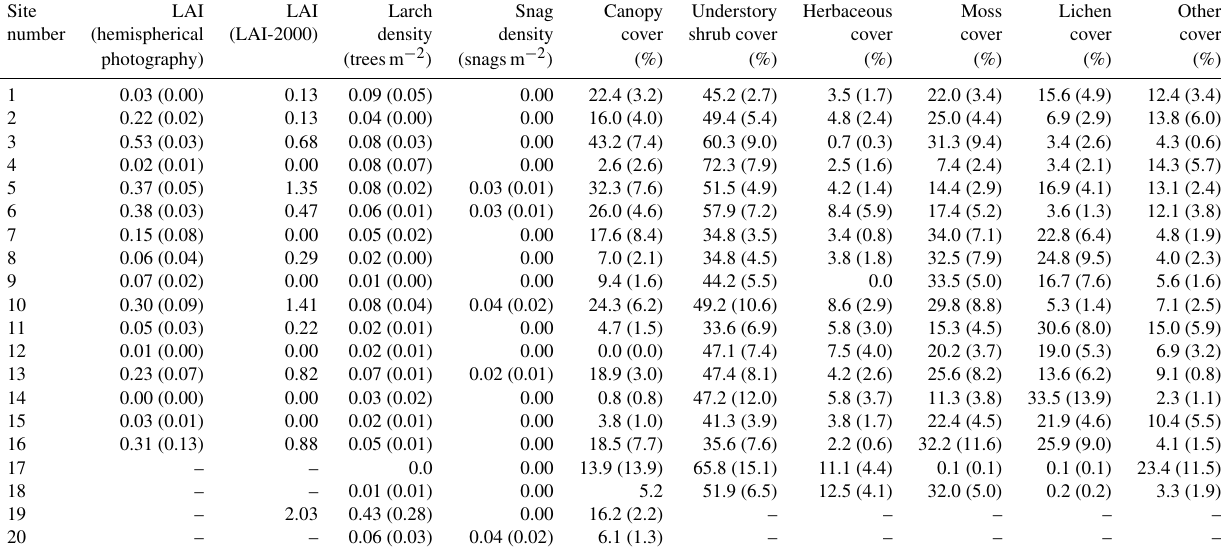
Table 2. Leaf area index (LAI), tree and snag density, and percent cover of the 20 plots in the Y4 watershed. Values in parentheses are standard error of the mean. “Other cover” includes woody debris and bare ground.